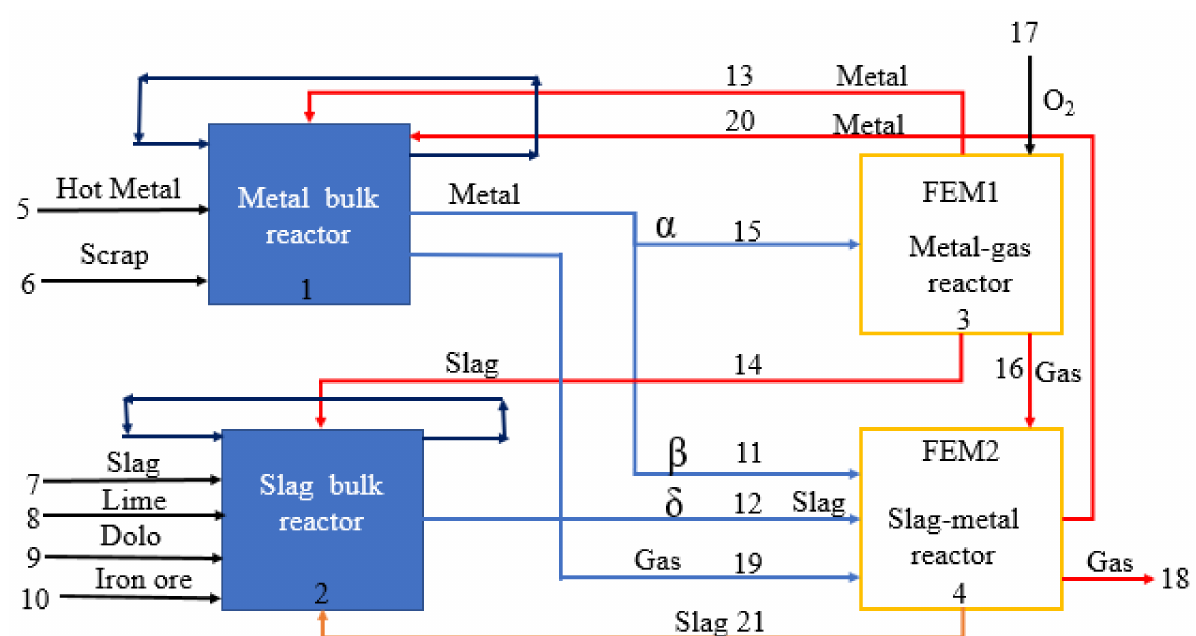
Figure 1. Flowsheet of multiple-reactor-based BOF steel-making